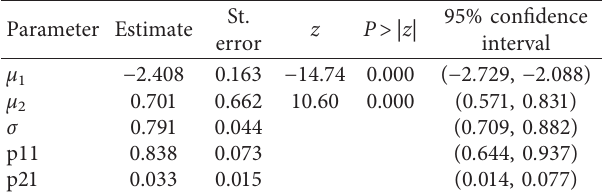
Table 1: Markov-switching regression in means only for sensitivity. Parameter Estimate